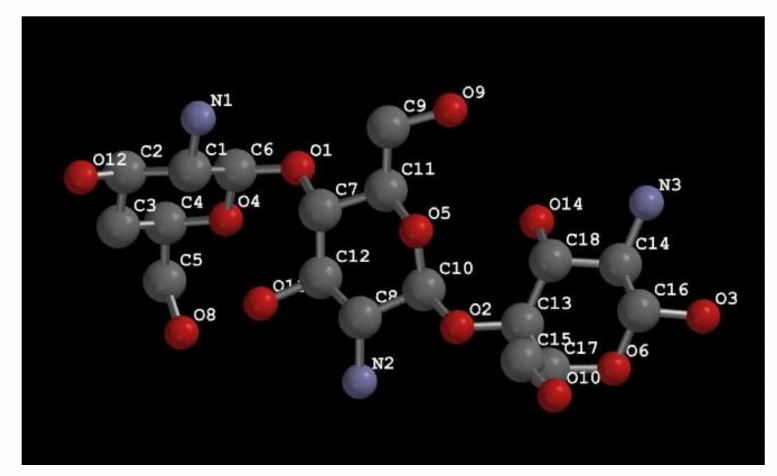
Figure 1. Structural design and chemistry of chitosan.